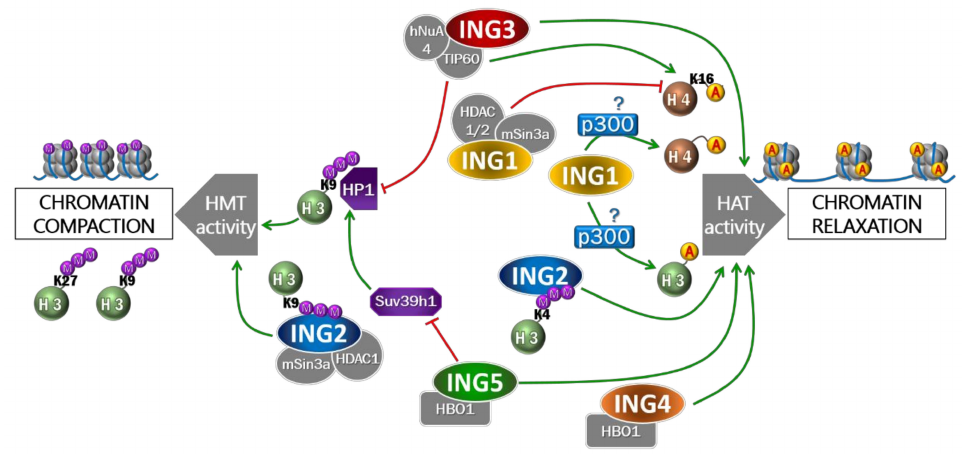
Figure 2. ING proteins participate in chromatin remodeling. Chromatin compaction is regulated by posttranslational modifications such as histone methylation (mostly recognized as a compacted chromatin hallmark), and histone acetylation (favoring chromatin relaxation). ING1, in complex